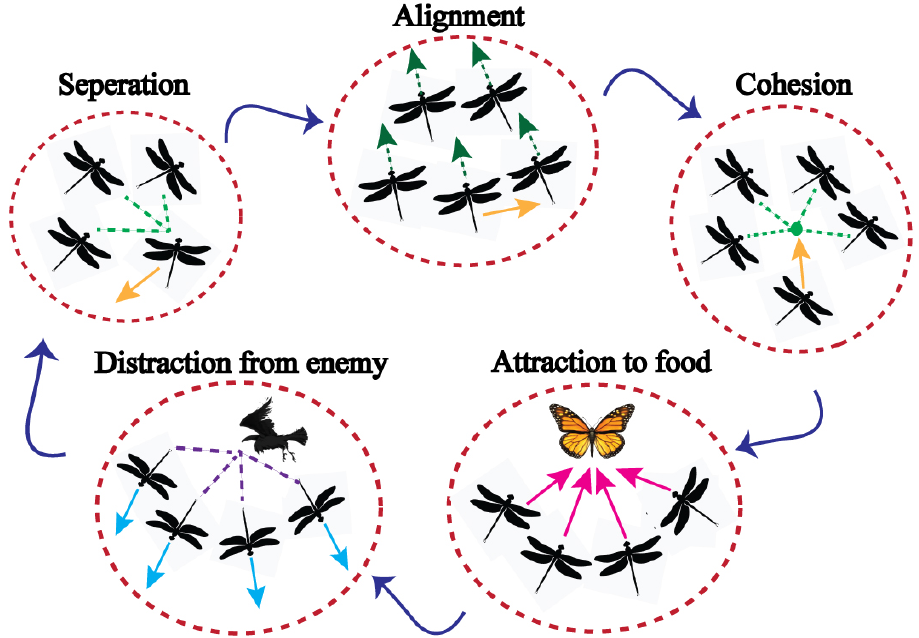
Figure 5. The primitive pattern of DFO